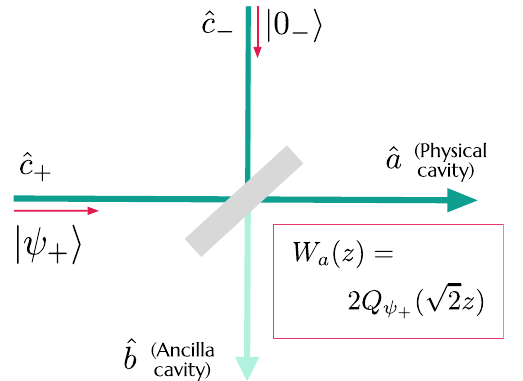
FIG. 2. Simple picture of the unique steady state of the generalized driven-Kerr resonator with nonzero single-photon loss. One starts with a pure-state, single-mode wave function j ψ i . This is mixed with vacuum noise at a 50 ∶ 50 beam splitter; þ the output ports represent the final steady state of the physical a cavity and the auxiliary b cavity. This operation implies that the cavity- a steady state is j ψ i convolved with vacuum noise. As a þ z Þ is equal (up result, cavity- a ’ s steady-state Wigner function W a ð to scaling) to the Q function Q ψ ð z Þ of the pure state j ψ i . þ þ